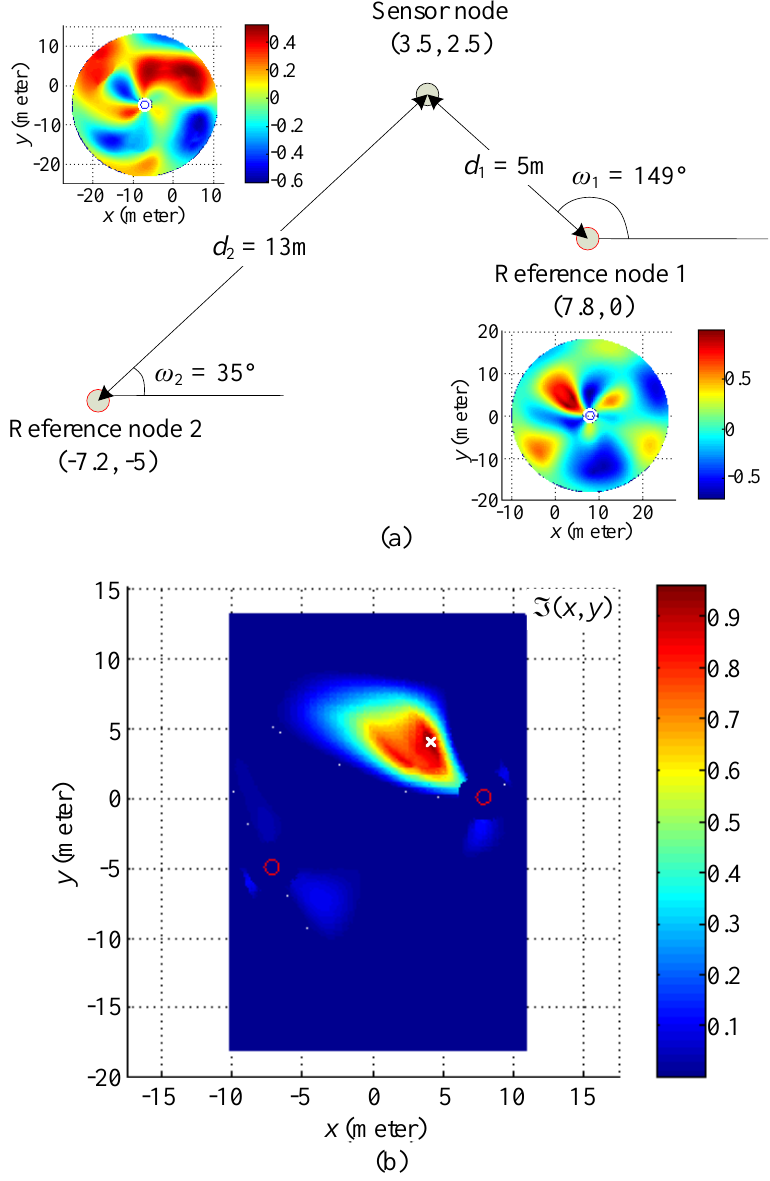
Figure 14. Experimental result for two reference nodes scenario. (a) Deployment arrangements of the sensor node and the reference node in a scenario for two-reference nodes. (b) Overall solution space with coordinates of reference nodes (red circles ○ ) and estimated coordinate (white cross × ) of the sensor